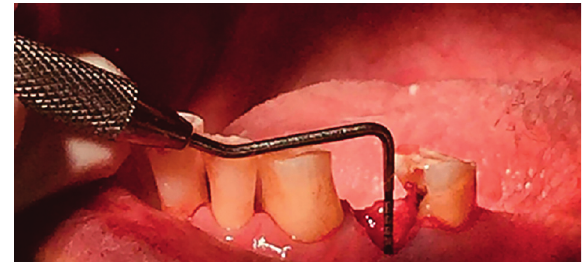
Figure 2: Measurement of the wound socket depth using a periodontal probe. The reference point was measured at the middle of the buccal gingiva between the adjacent